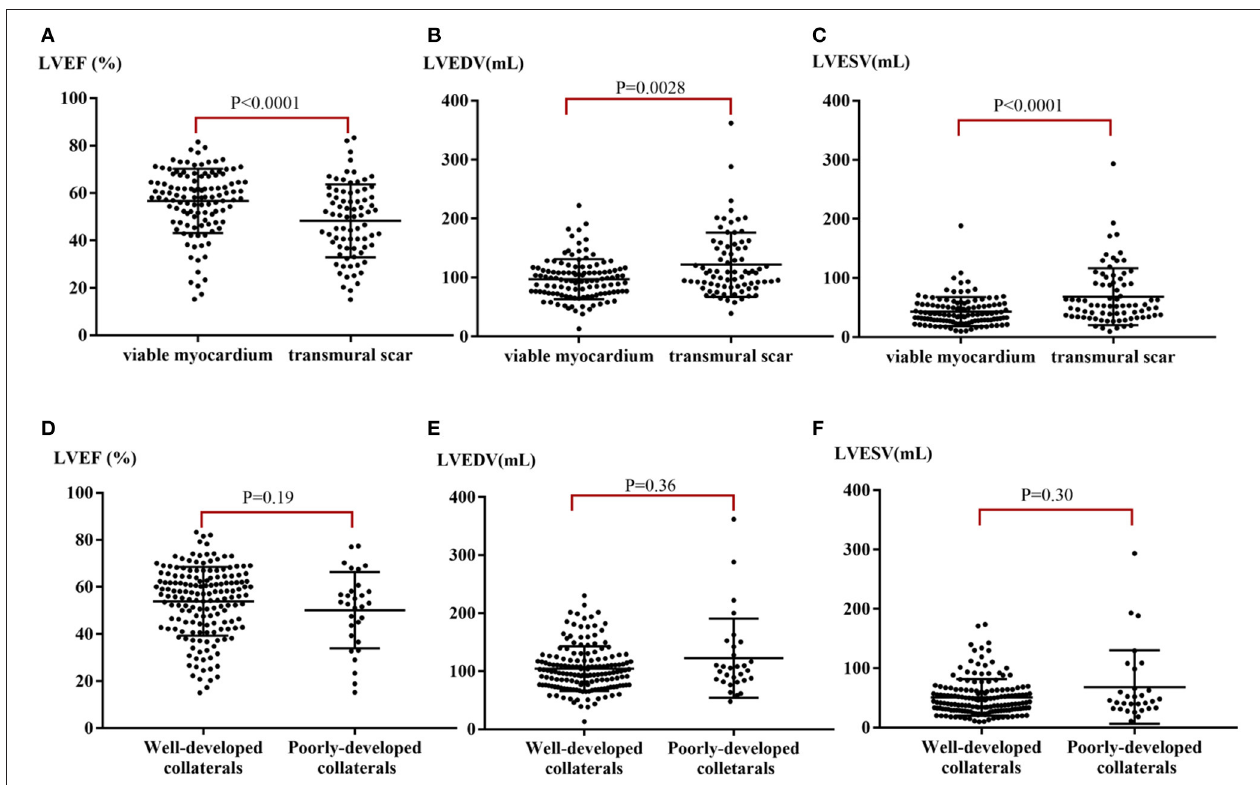
FIGURE 2 | LV function stratified by myocardial viability and collaterals. (A) Median LVEF stratified by the extent of myocardial scar. (B) Median LVEDV stratified by the extent of myocardial scar. (C) Median LVESV stratified by the extent of myocardial scar. (D) Median LVEF stratified by well- or poorly-developed collaterals. (E) Median LVEDV stratified by well- or poorly-developed collaterals. (F) Median LVESV stratified by well- or poorly-developed collaterals. LVEF, left ventricular ejection fraction; LVEDV, left ventricular end-diastolic volume; LVESV, left ventricular end-systolic